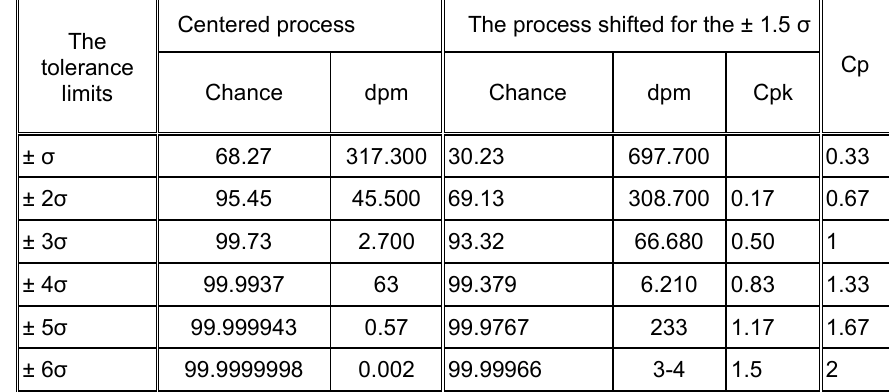
Table 2 – The defect levels of centered and shifted processes Таблица 2 – Концентрация деффектов процессов центрирования и перемещения центра Tabela 2 – Nivo defektnosti centriranih i pomerenih procesa The process shifted for the ± 1.5 σ The